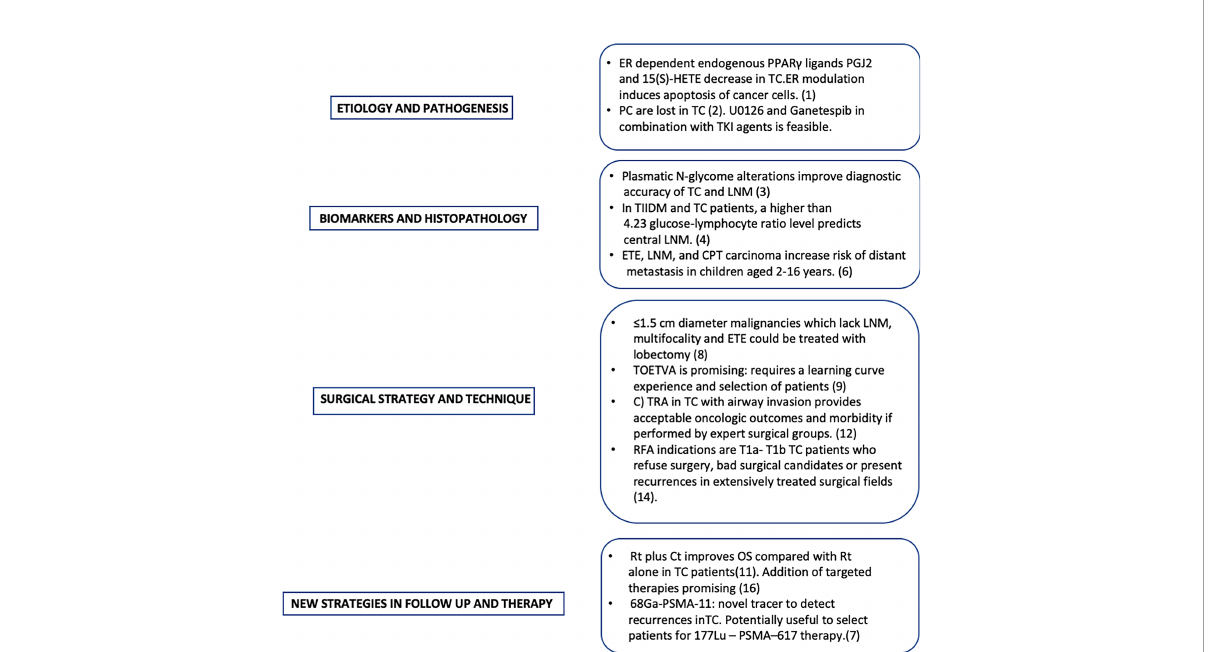
FIGURE 1 Pivotal Findings Regarding New Strategies In Treatment Of Thyroid Carcinoma: Er, Estrogen receptors; PC, Primary cilia, TC, Thyroid carcinoma; LNM, Lymph Node Metastasis; IIDM, Type II Diabetes Mellitus; ETE, Extrathyroid extension; CPT, Classic Papillary Thyroid; TOETVA, Transoral endoscopic thyroidectomy vestibular approach; (C)TRA Cricotracheal and tracheal resection with end to end anastomosis; RFA, Radiofrecuency Ablation; RT, radiotherapy; CT, Chemotherapy; OS, Overall